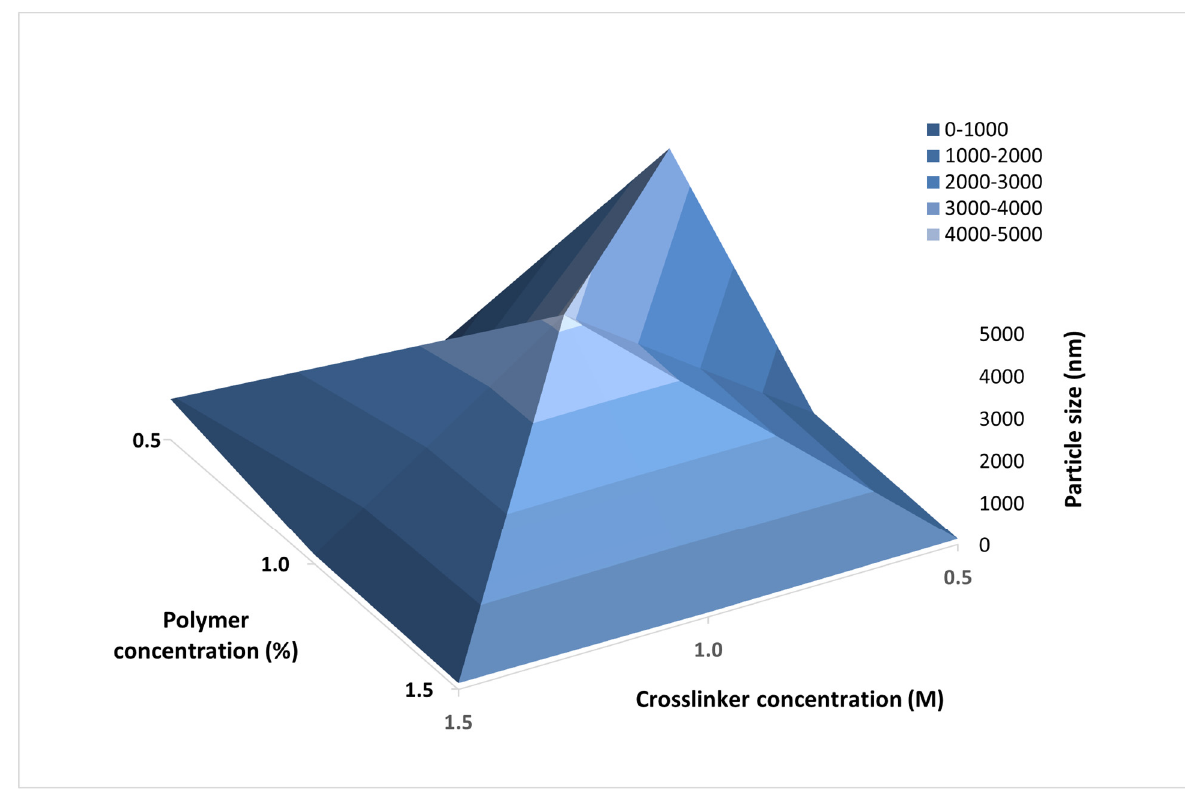
Figure 1. 3D plot representing the impact of the concentration of the polymer and the crosslinking agent on the mean particle size of blank casein spray dried nanoparticles.